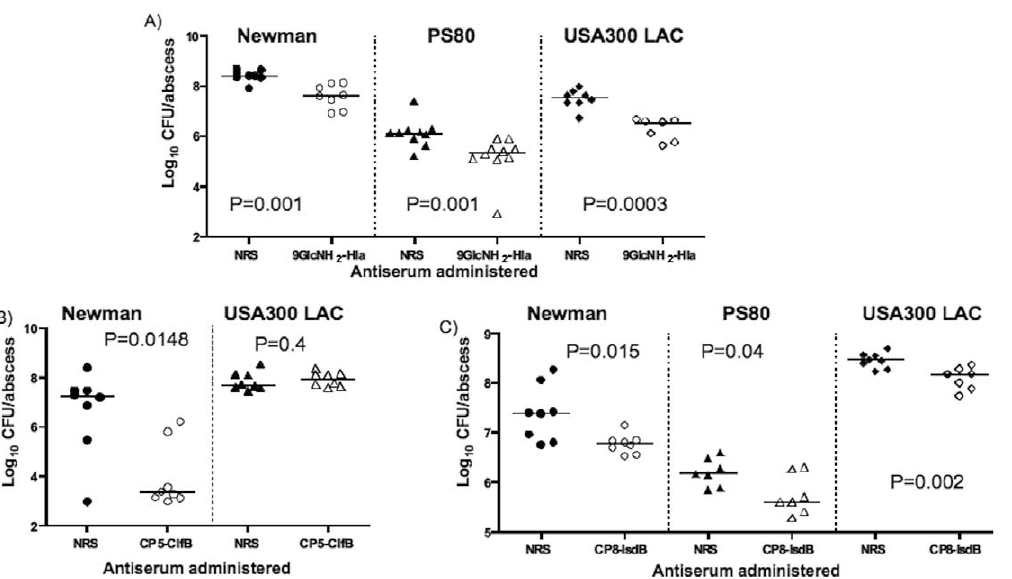
USA300 LAC. (C) Results following immunization with CP8-IsdB antisera or NRS and challenge with S. aureus Newman, PS80 or USA300 LAC; (p values determined by Mann-Whitney test.